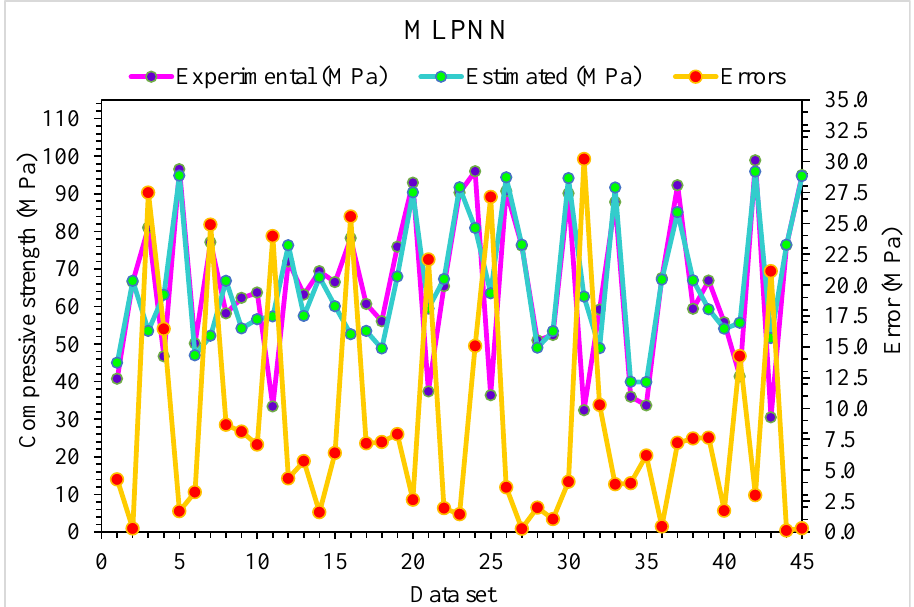
Figure 5. Experimental and MLPNN predicted values with errors for compressive strength.